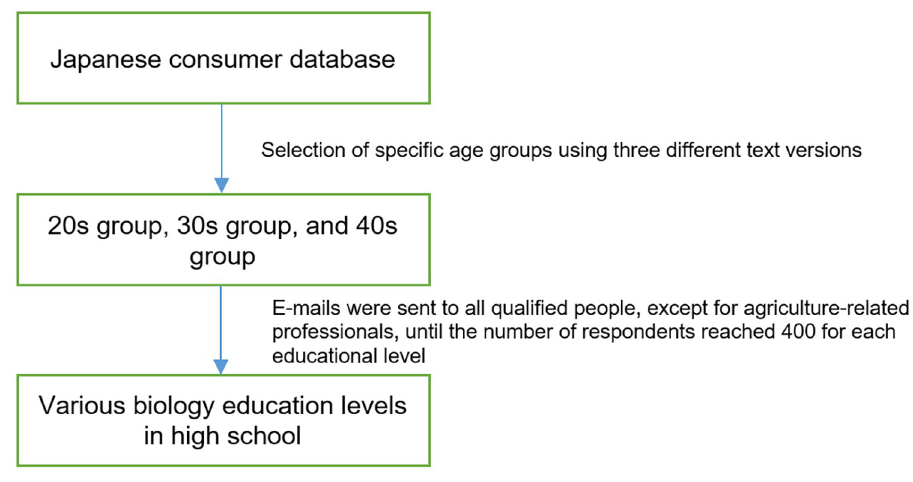
Fig 1. Data collection